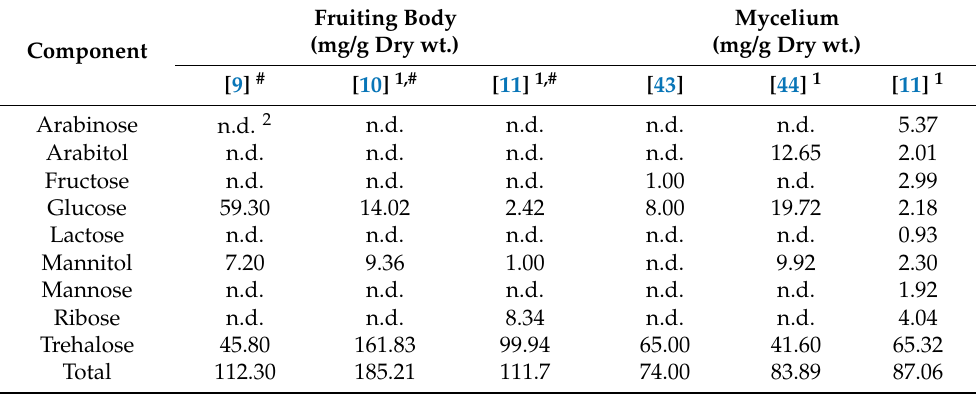
Table 2. Soluble sugar content of G. frondosa fruiting body and mycelium in dry weight. Fruiting Component